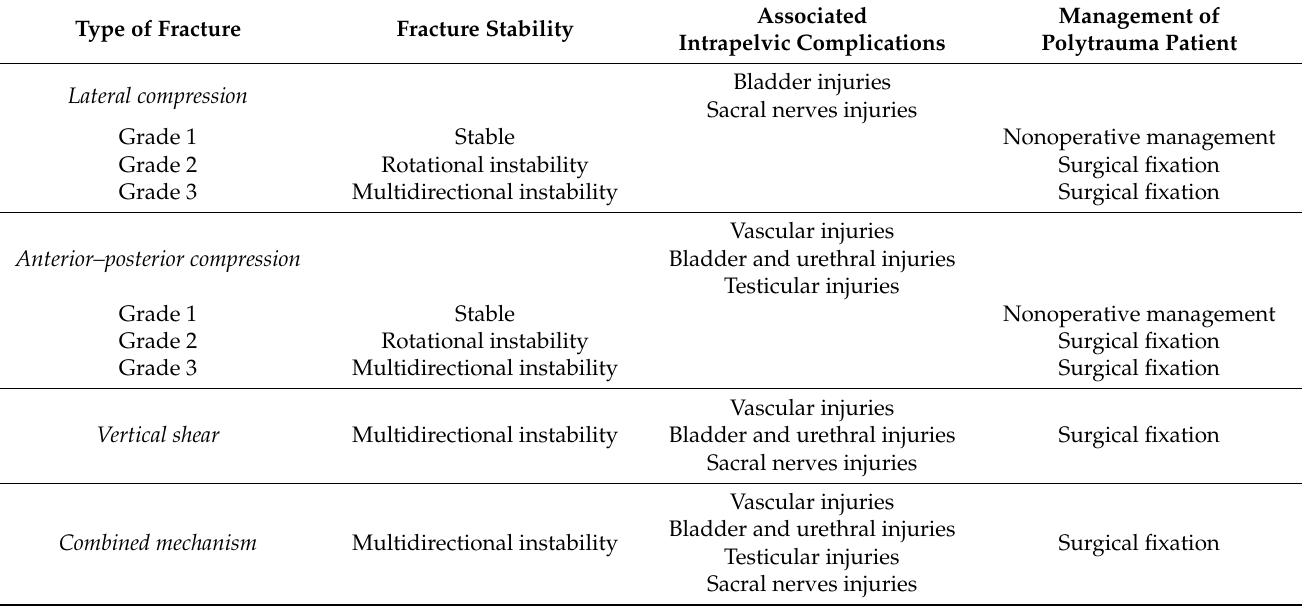
Table 1. Young and Burgess classification, and its correlations with associated intrapelvic complica- tions and with